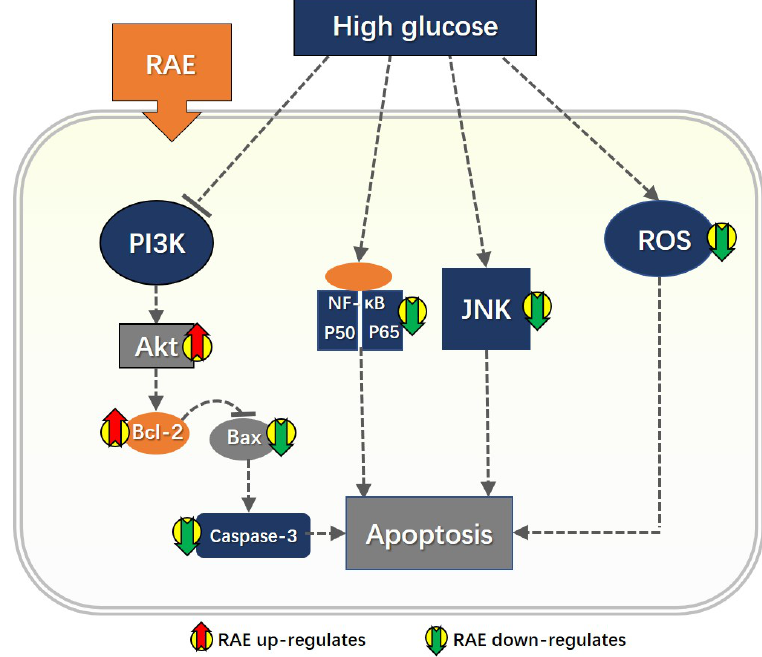
Figure 7. High glucose stimulated reactive oxygen species (ROS) production and promoted the activity of caspase-3. It also inhibited Akt activation, broke the balance between Bcl-2/Bax, and activates NF- κ B and JNK activation, which are all accompanied by a higher apoptosis rate in endothelial cells compared with the normal group, indicating that these pathways were closely related to the apoptosis of endothelial cells under high-glucose conditions. Furthermore, the treatment of RAE could significantly reverse the effects caused by high glucose. Thus, RAE might have a close relationship with these pathways, which were involved with high glucose-induced apoptosis. However, the interactions among these pathways were not